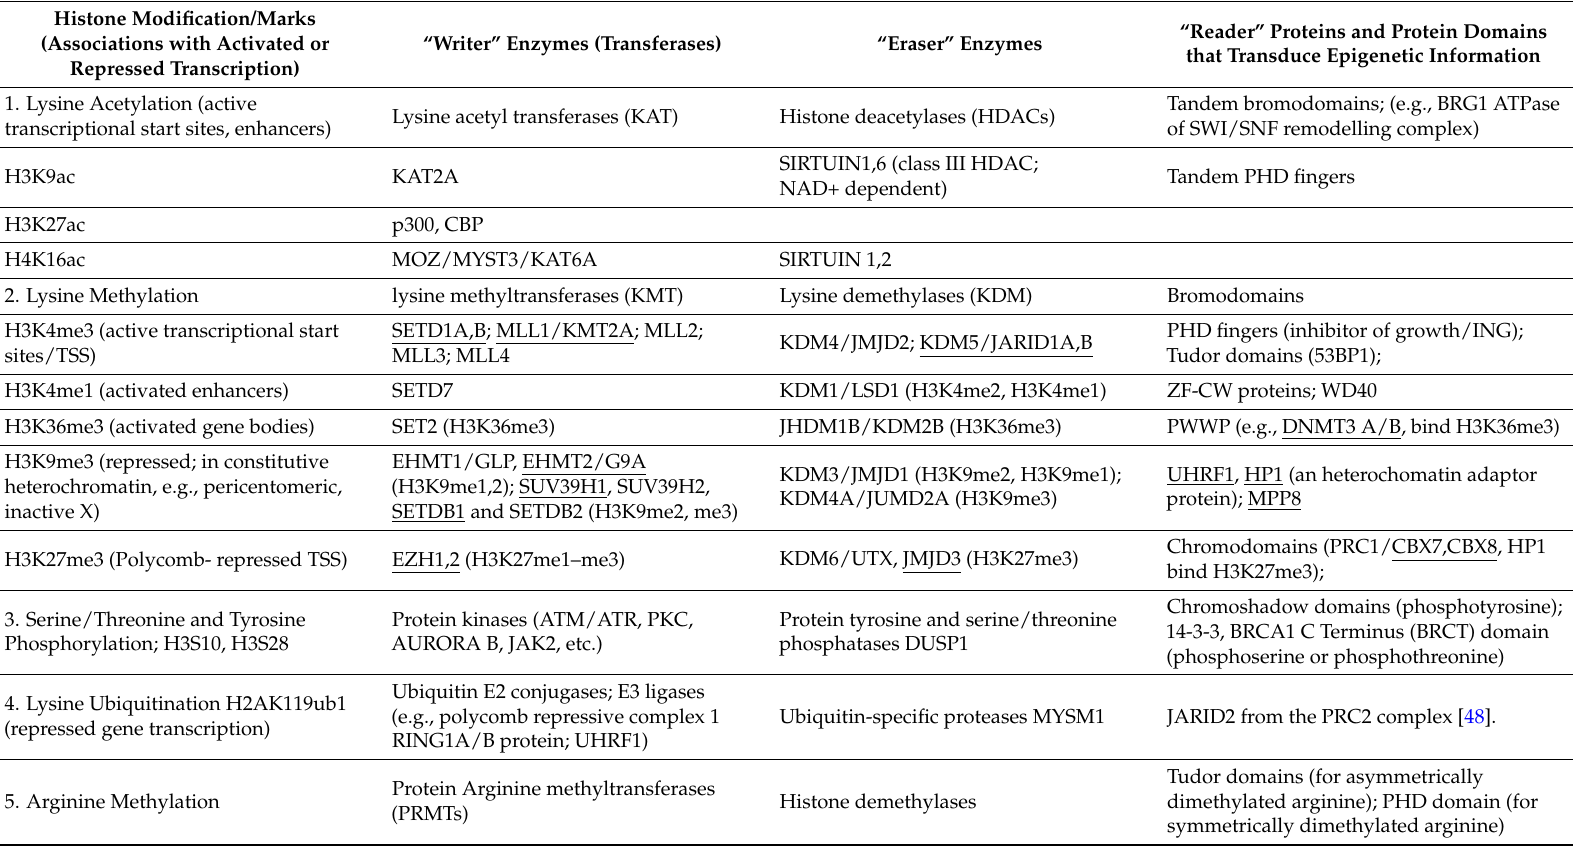
Table 1. Classification of functions among the well-studied, cancer-associated histone modification systems *. Histone Modification/Marks (Associations with Activated